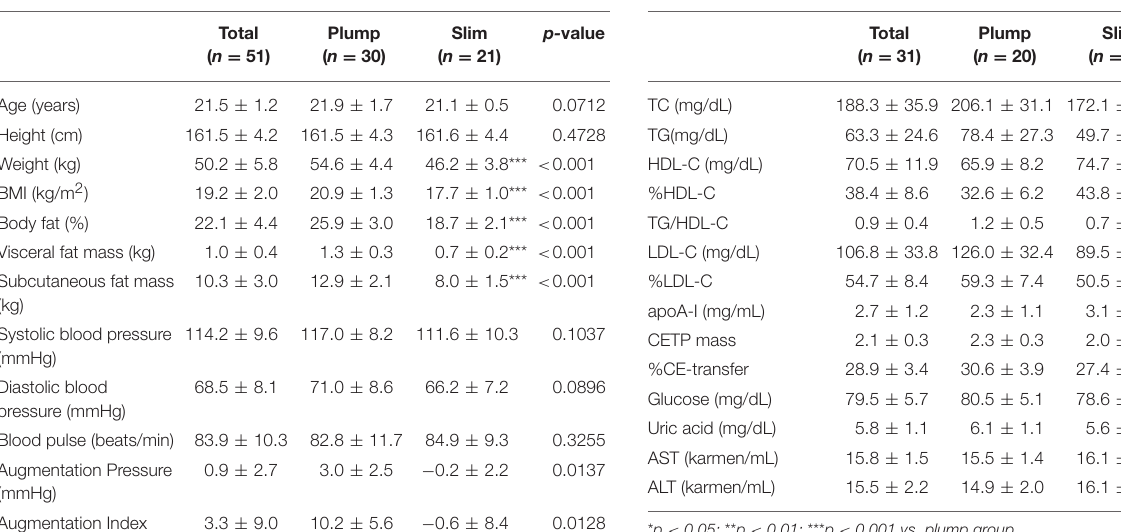
TABLE 1 | Anthropometric